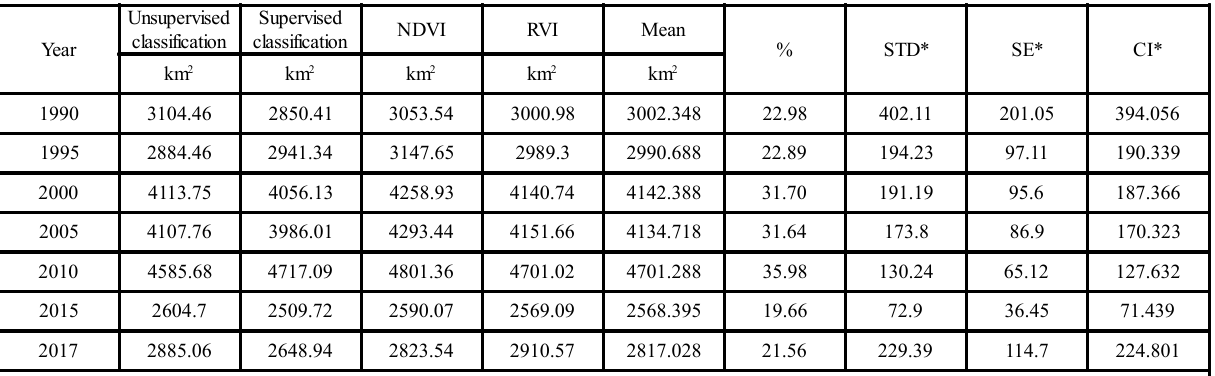
TABLE 3. STATISTICAL SUMMARY OF THE TEMPORAL VARIATION IN THE VEGETATION OF THE INDUS DELTA (1990-2017)